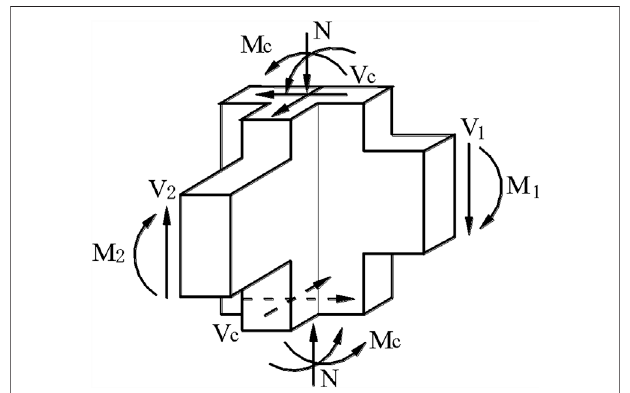
FIGURE 12 | Stress mechanism of joints.